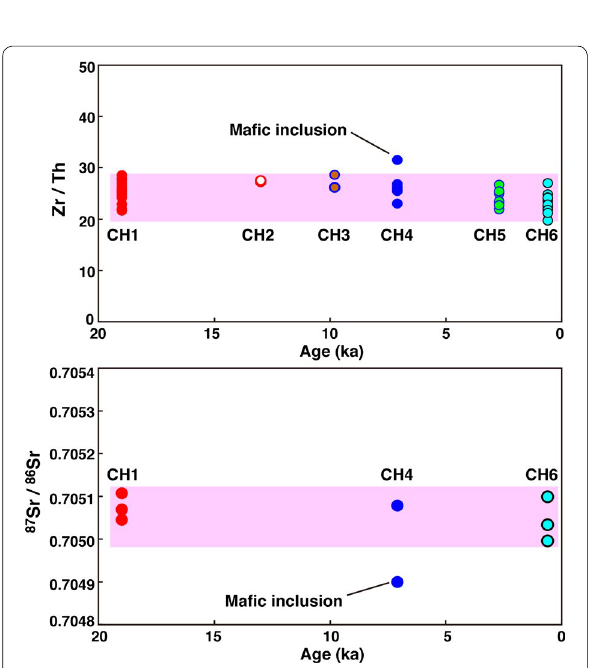
Fig. 15 Temporal variations of Zr/Th and 87 Sr/ 86 Sr in the products of Nasu-Chausudake Volcano. Abbreviations are same in Fig. 14. Data are from this study (Additional file 2: Appendix 2)